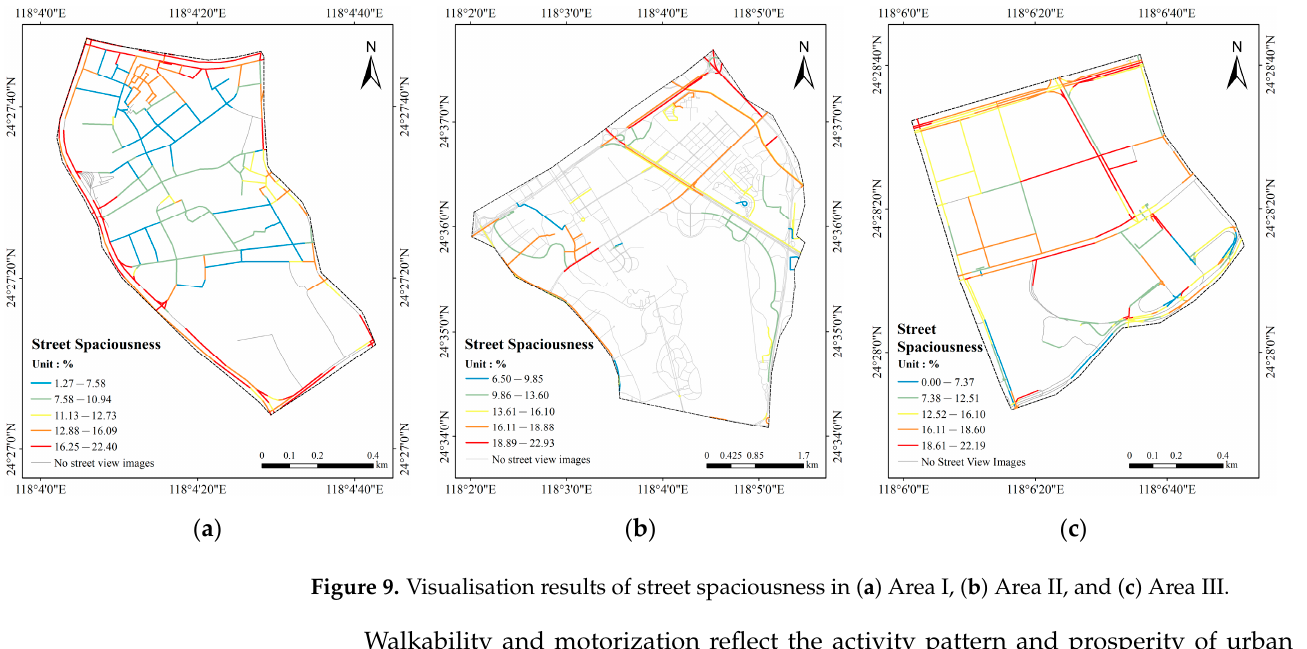
( c ) Figure 8. Visualisation results of spatial openness in ( a ) Area Ⅰ , ( b ) Area Ⅱ , and ( c ) Area Ⅲ .